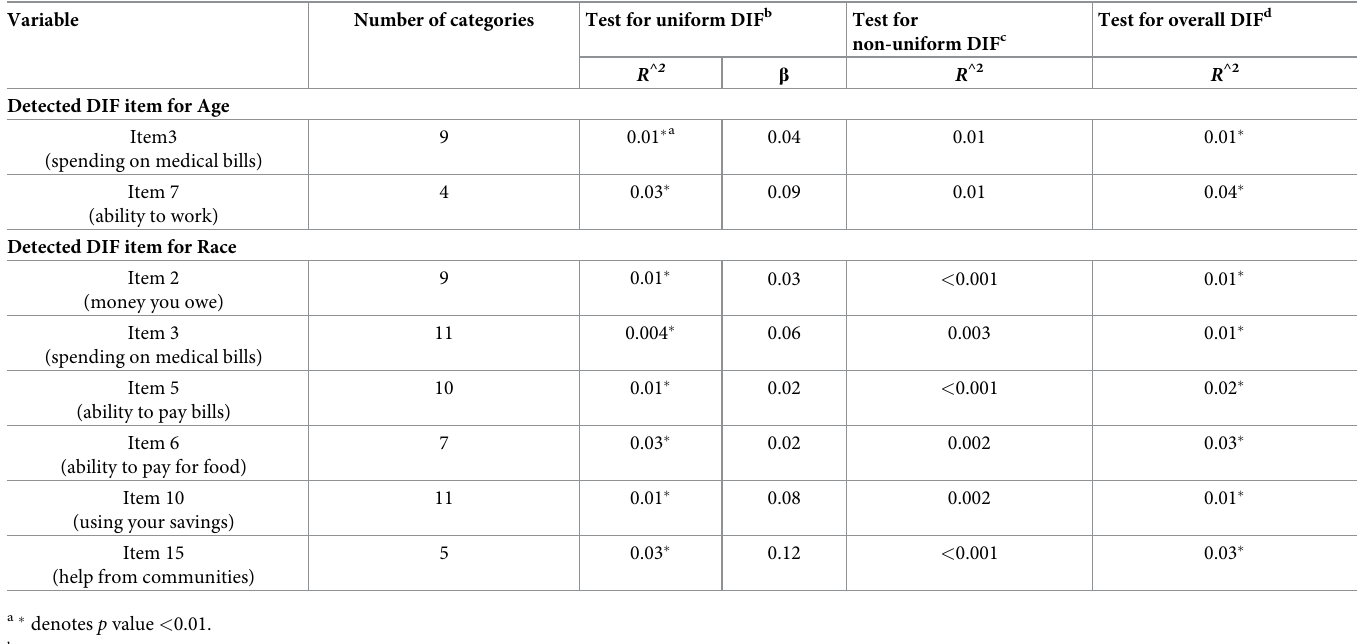
Table 2. Comparison results of significant DIF among younger vs old adults and non-white vs white patients using ordinal logistic regression models.